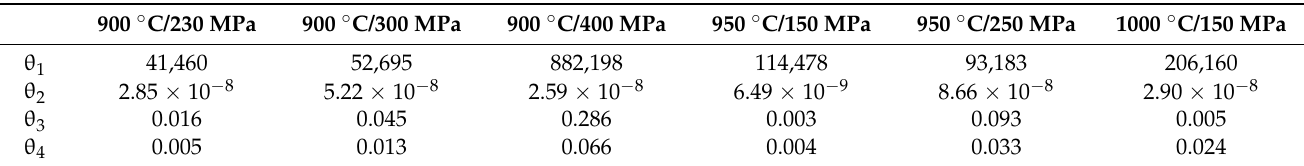
Table 3. θ i values obtained in MarM247LC superalloy by fitting the six creep curves corresponding to 0~10% creep strain range.